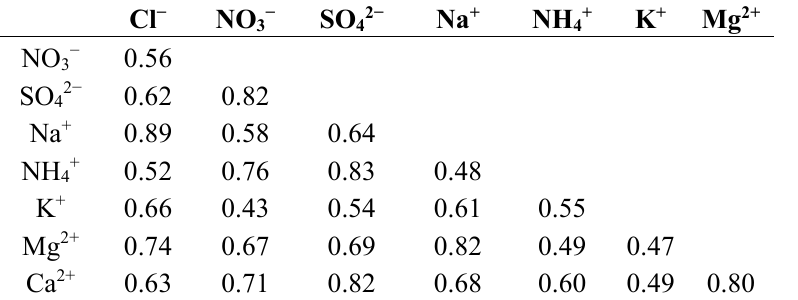
Table 4. Correlations between ionic components in wet-only precipitation over seven years in the Shihwa Basin ( p < 0.001 for all correlation). − SO 42 − Na Cl − NO 3